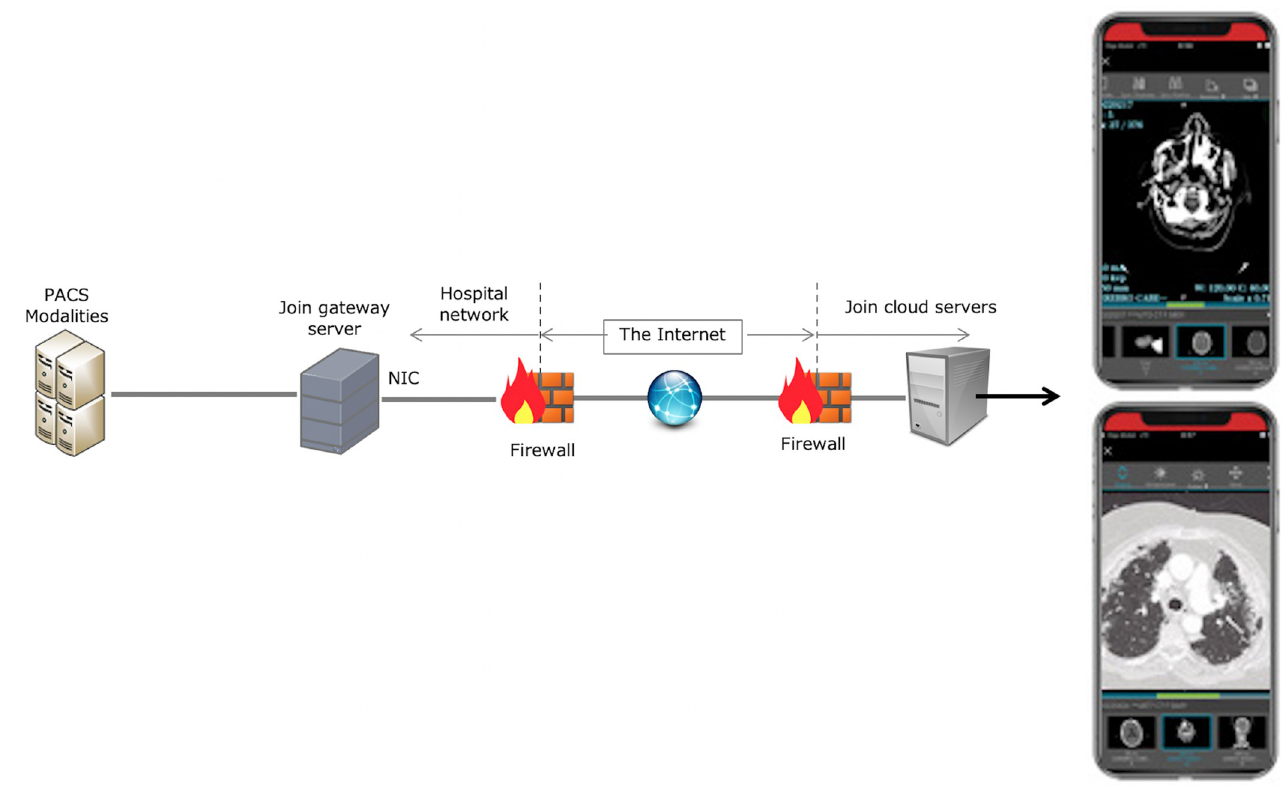
Fig 1. Example of encrypted image system for acute stroke code using the JOIN app.